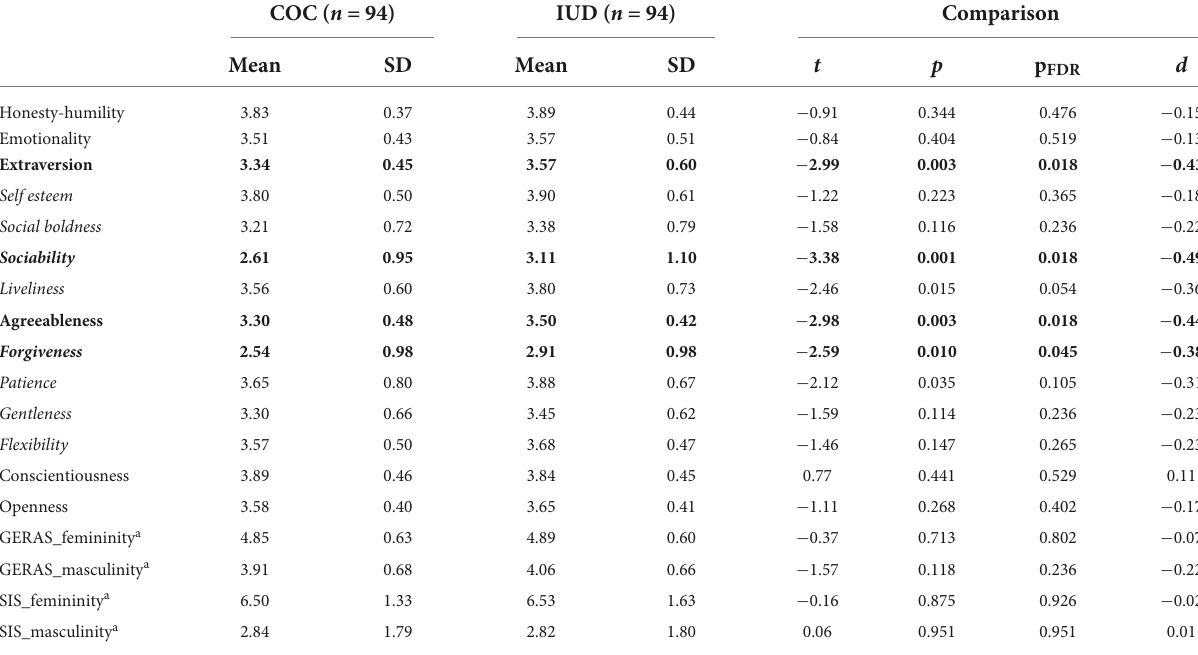
TABLE 6 Personality differences between IUD-users and COC-users matched for age, language, sexual orientation, relationship status, education, and employment status. COC ( n = 94) IUD ( n = 94)